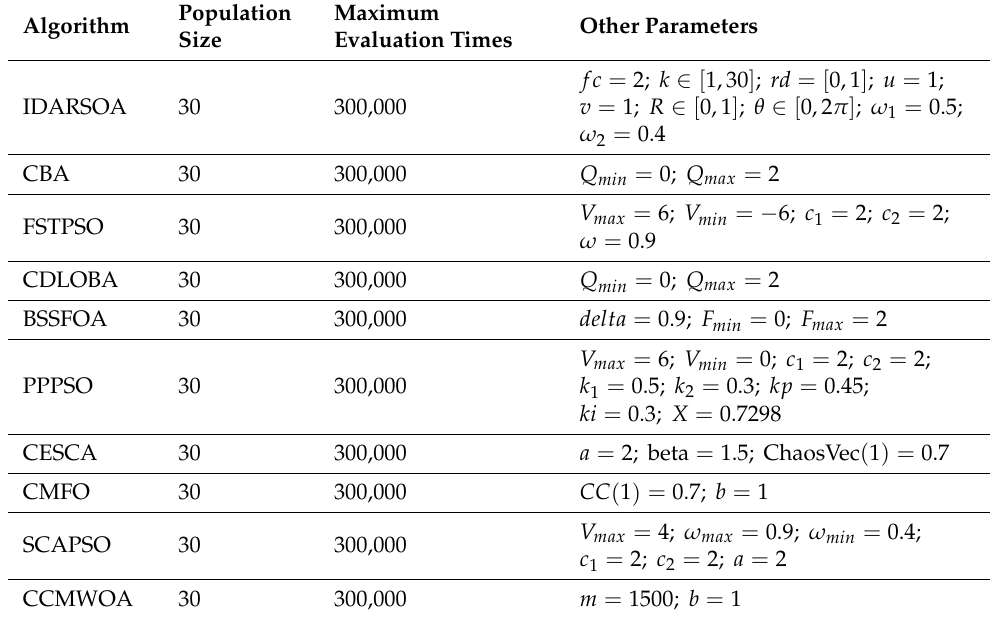
Table 9. Parameter settings of advanced algorithms.